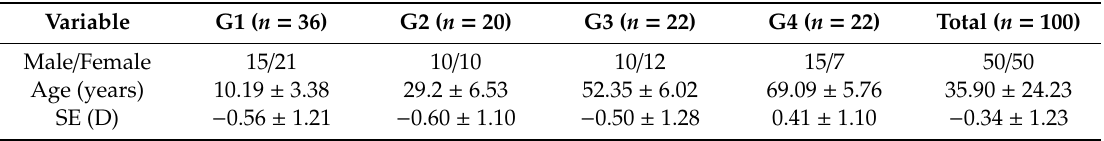
Table 1. Demographic data from healthy participants in the study.